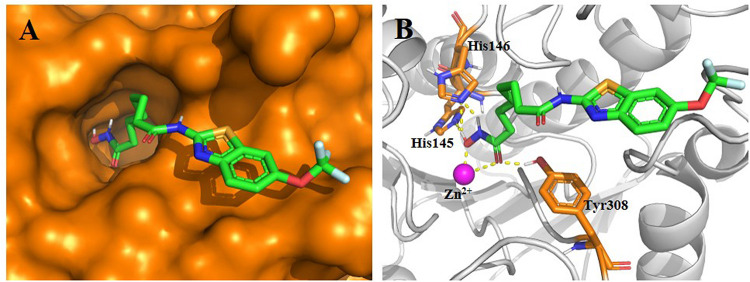
Proposed binding mode of compound 1 (green) with HDAC2 (PDB code 4LXZ). (A) Surface of HDAC2 with compound 1. (B) Detailed interactions between HDAC2 and compound 1. Yellow dashed lines represent the hydrogen bonds. Oxygen, nitrogen, fluorine, sulfur, and polar hydrogen atoms are shown in red, blue, pale cyan, bright orange, and white, respectively. The Zn2+ is shown as a magenta sphere. The figure was generated using PyMol (http://www.pymol.org/).